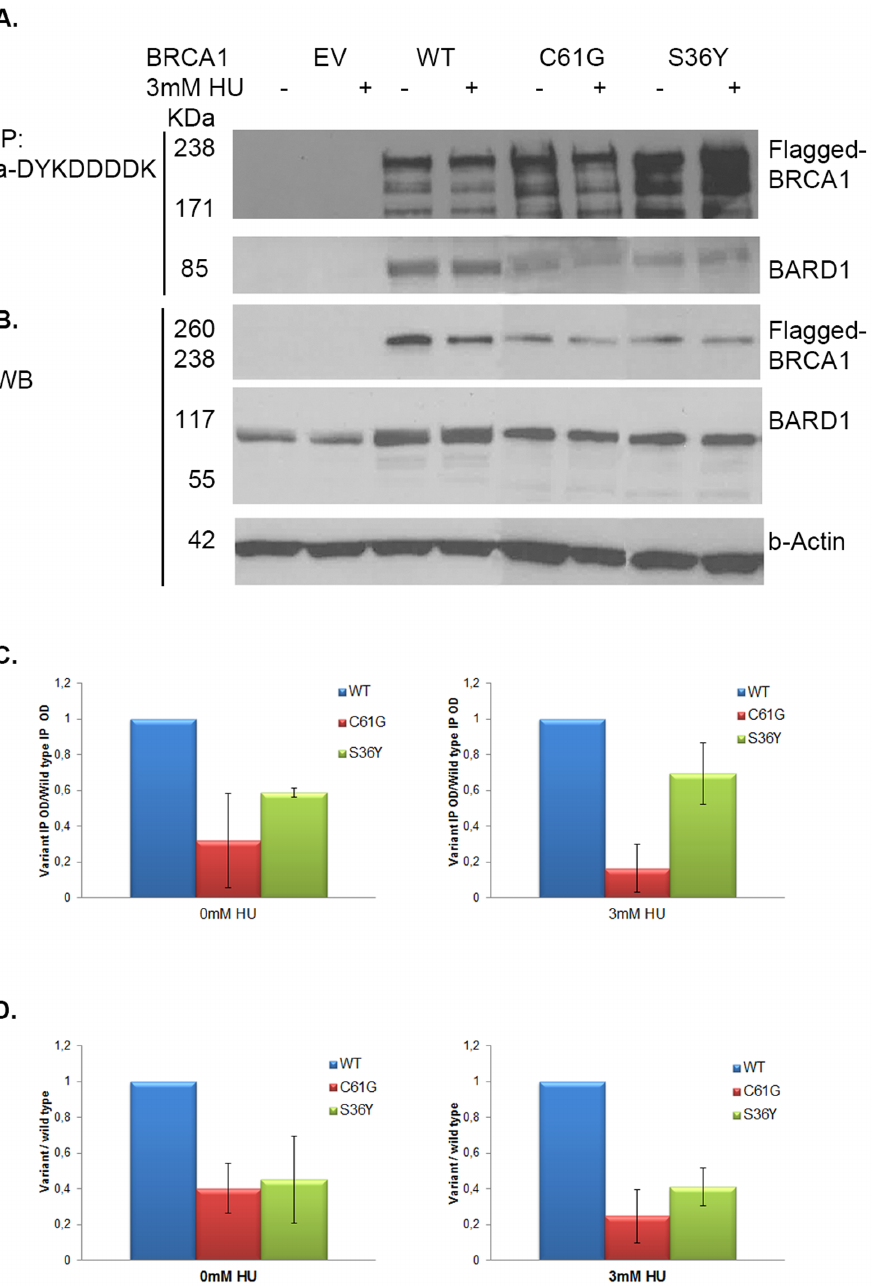
Figure 2. p.Ser36Tyr (S36Y) BRCA1 variant demonstrates reduced ability to interact with BARD1 in S-phase synchronized cells. A. Exogenously expressed BRCA1 co-precipitates with BARD1 in cells that were co-transfected with BRCA1 and BARD1, S-phase synchronized and treated with HU. Immunoblot analysis of the pull-downs performed with the anti-DYKDDDDK tag antibody which recognizes only the epitope- tagged exogenous BRCA1 protein, demonstrated that BARD1 levels co-precipitated by wild type BRCA1 are higher than those co-precipitated by each of the p.Ser36Tyr and p.Cys61Gly (C61G) variants in both resting or HU treated cells. B. Immunoblot analysis of whole cell extracts detected decreased BARD1 and exogenous BRCA1 expression in p.Ser36Tyr and p.Cys61Gly BRCA1 variant transfected cells compared to the wild type transfected cells. b -actin served as loading control. C. Bar charts comparing the levels of BARD1 co-precipitated by p.Ser36Tyr and p.Cys61Gly variant with wild type BRCA1 in untreated cells or cells treated with HU, demonstrate that both variants exhibit reduced ability to interact with BARD1 compared to wild type BRCA1. D. Bar charts showing the expression levels of wild type BRCA1 and p.Ser36Tyr and p.Cys61Gly variants following normalization with b -actin in whole cell extracts, demonstrate that both variants are expressed at lower levels compared to wild type BRCA1. The results are representative of 3 experiments. doi:10.1371/journal.pone.0093400.g002 cells compared to the wild type protein, but nevertheless it co- microscopy. As seen in Fig. 3, the p.Ser36Tyr BRCA1 variant localized with BARD1, thus supporting the immunoprecipitation exhibited reduced expression levels in the nucleus of transfected findings that the interaction is not entirely abolished. In